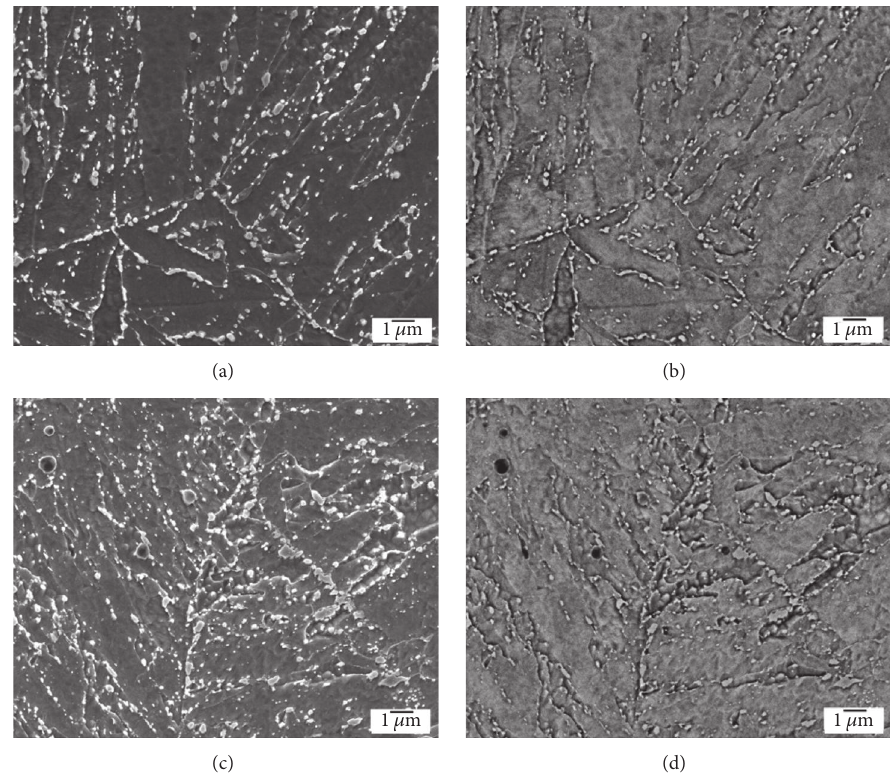
Figure 2: SEM-micrographs of initial PWHT microstructures of BM (a, b) and WM (c, d) of the CB2 weldment visualized using secondary electrons (a, c) and back-scattered electrons (b,